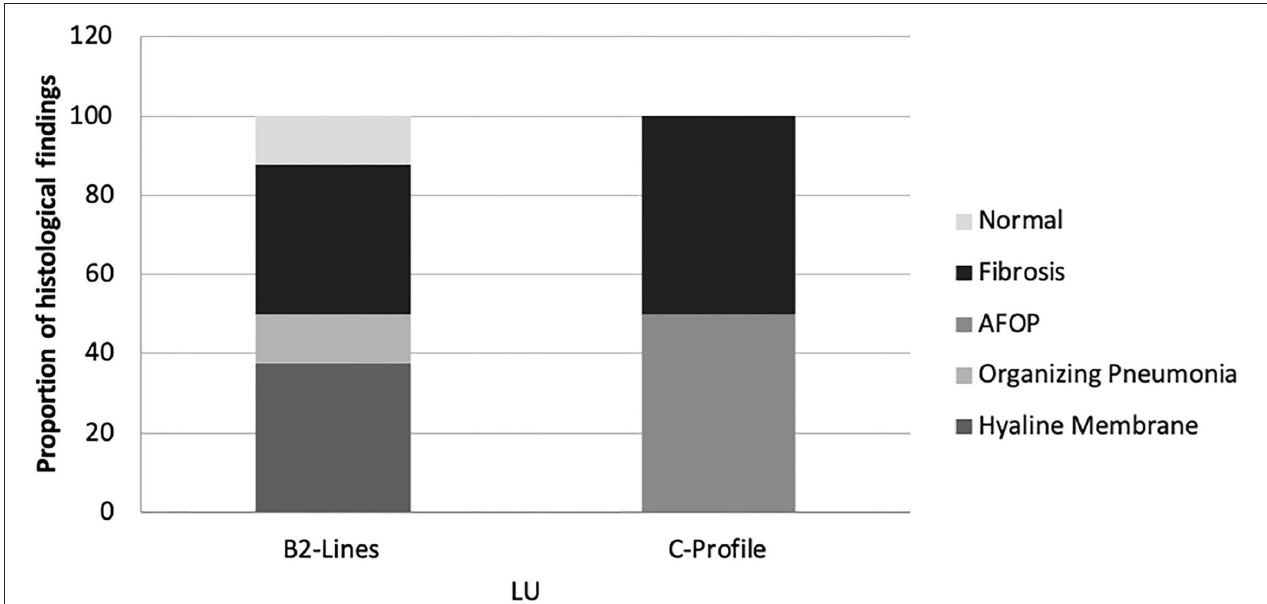
FIGURE 3 | Proportion of histological findings in function of LU images. AFOP, Acute Fibrinous Organizing Pneumonia; LU, Lung